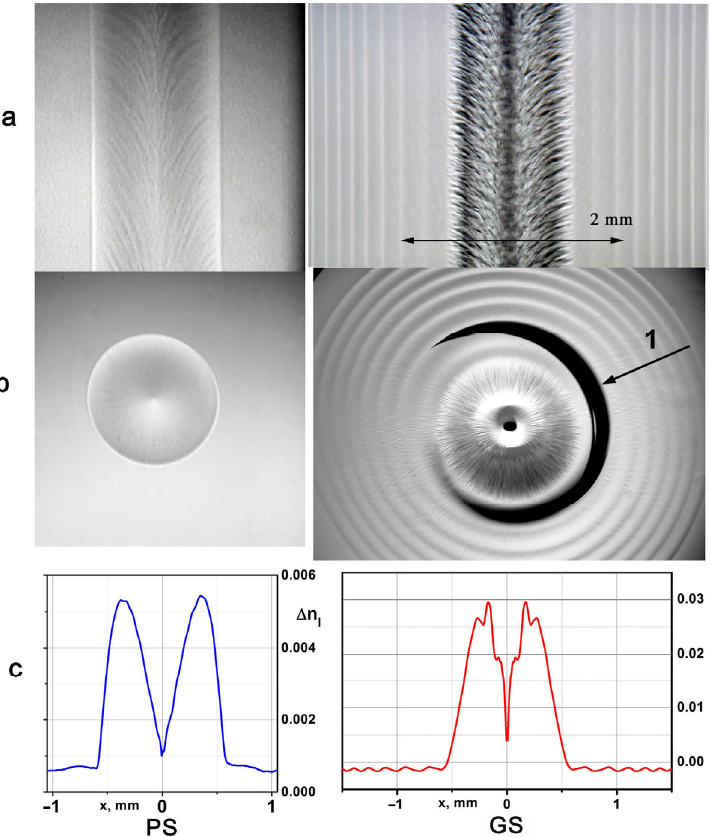
Figure 2. (PS) The PS preform data: ( a ) picture of the smooth core–cladding interface taken in the direction perpendicular to the preform axis; ( b ) a cross-section of the preform with core in the center; ( c ) RI profile of the PS preform. (GS) The GS preform data: ( a ) picture of the “hedgehog” shape of core–cladding interface taken in the direction perpendicular to the preform axis; ( b ) a cross-section view with “star” and an annular crack around the core ( 1 ), formed during the processing of a cross- sectional specimen. ( c ) RI profile of the GS preform. The linear scale is the same for all pictures and is shown in the GS photo ( a ). Side-view pictures ( a ) were taken using